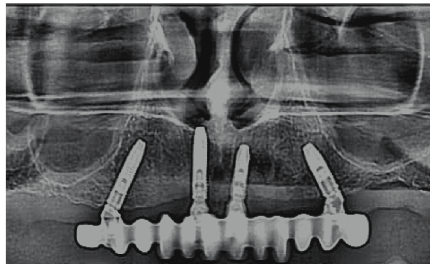
Figure 10: Control of the fit of a titanium bar of a permanent screw-retained multiunit-supported prosthesis.